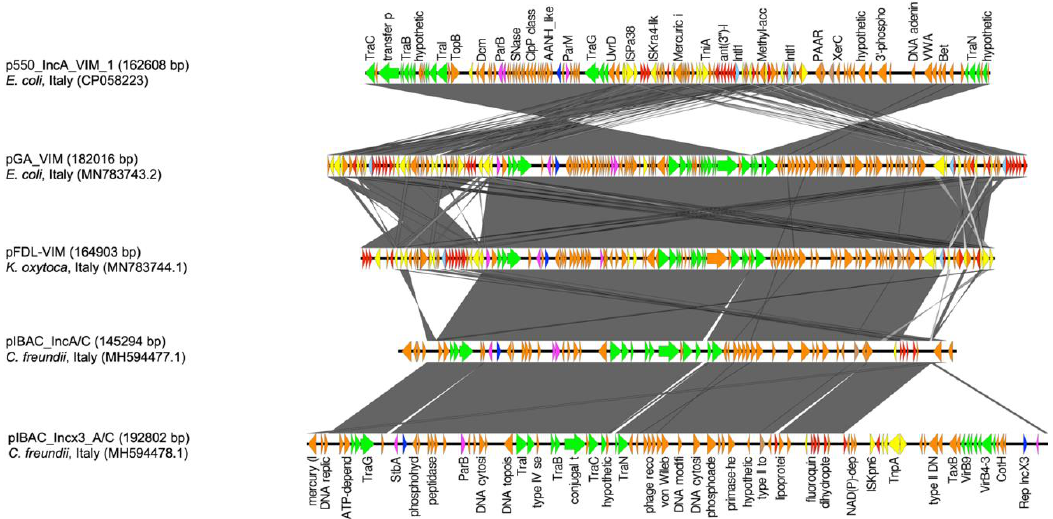
Figure 2. Genetic linear map of p550_IncA_VIM_1, pGA_VIM, pFDL-VIM, pIBAC_IncA/C, and pIBAC_Incx3_A/C. Replicons, partitioning genes, mobile elements, conjugal transfer genes, antibiotic resistance, and other remaining genes are designated by blue, purple, yellow, green, red, and orange, respectively. Gray shaded area shows nucleotide similarity.